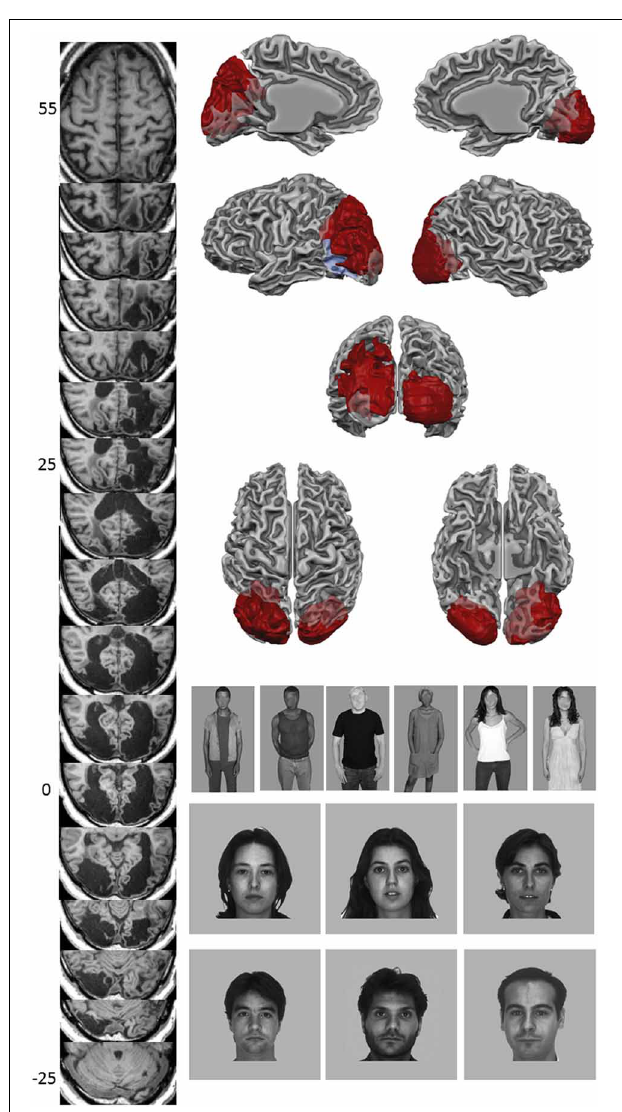
FIGURE 1 | Structural imaging results and stimulus examples. The left column shows a regular series of axial T1 scan slices. Coordinates refer to Talairach space. The top row right shows medial views of a cortical reconstruction of TN’s left and right hemisphere, with lateral views underneath. Below, a posterior view is shown, with underneath a dorsal (left) and ventral (right) view of TN’s cortical reconstruction of both hemispheres. Gyri are shown in light gray, sulci in dark gray, lesion in red, and ventricles in light blue. The bottom right panel shows stimulus examples of body and face